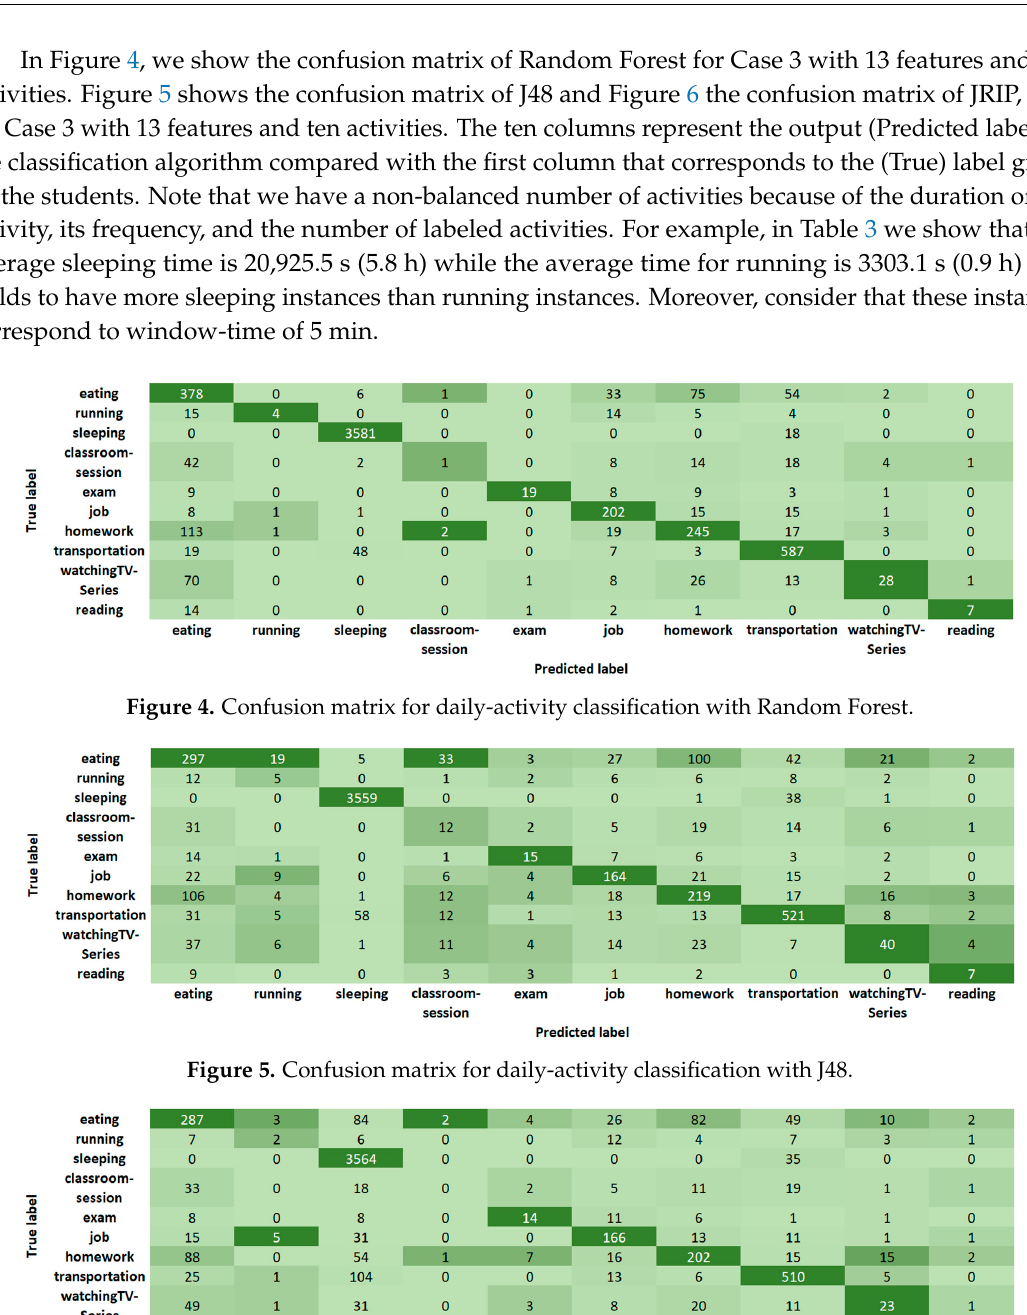
Table 7. Activity classification accuracy for MLP, Naïve Bayes, J48, Random Forest, and JRIP algorithms.